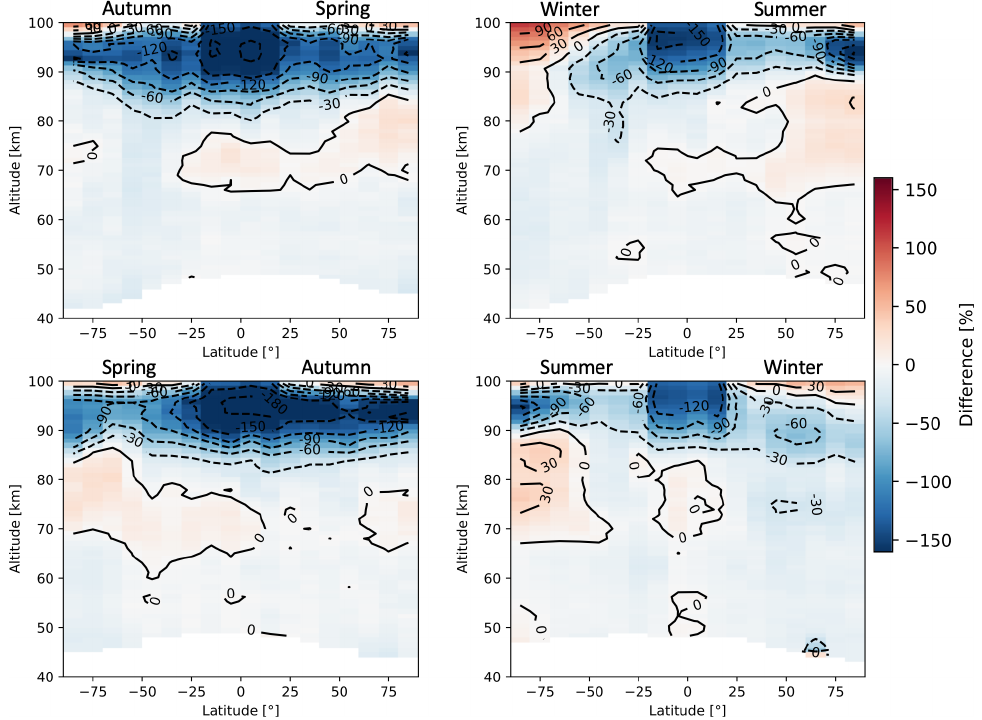
Figure A15. Seasonal zonal means of H 2 O FM19 SMR–MIPAS upper atmosphere relative differences averaged over the time period indi- cated in Table 2. The seasons are intended as astronomical seasons, i.e. each starting at the respective solstice or equinox.